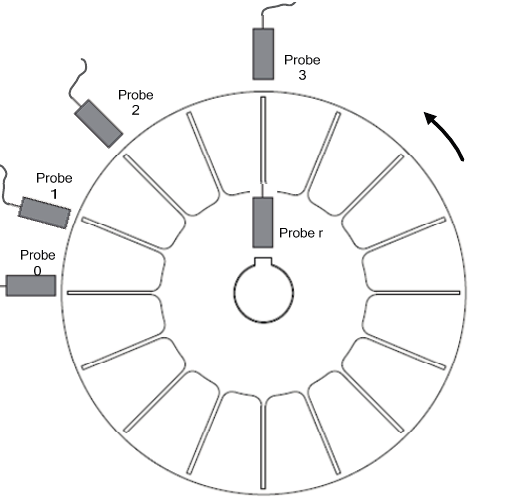
Figure 1. Schematic of the non-uniform BTT